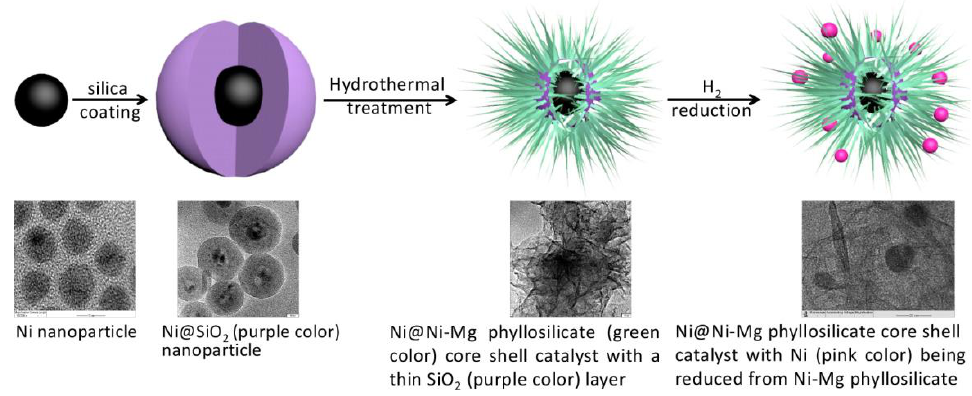
Figure 12. Schematic illustration of the formation process of Ni@Ni–Mg phyllosilicate core–shell catalyst. Reproduced with permission from reference [187].